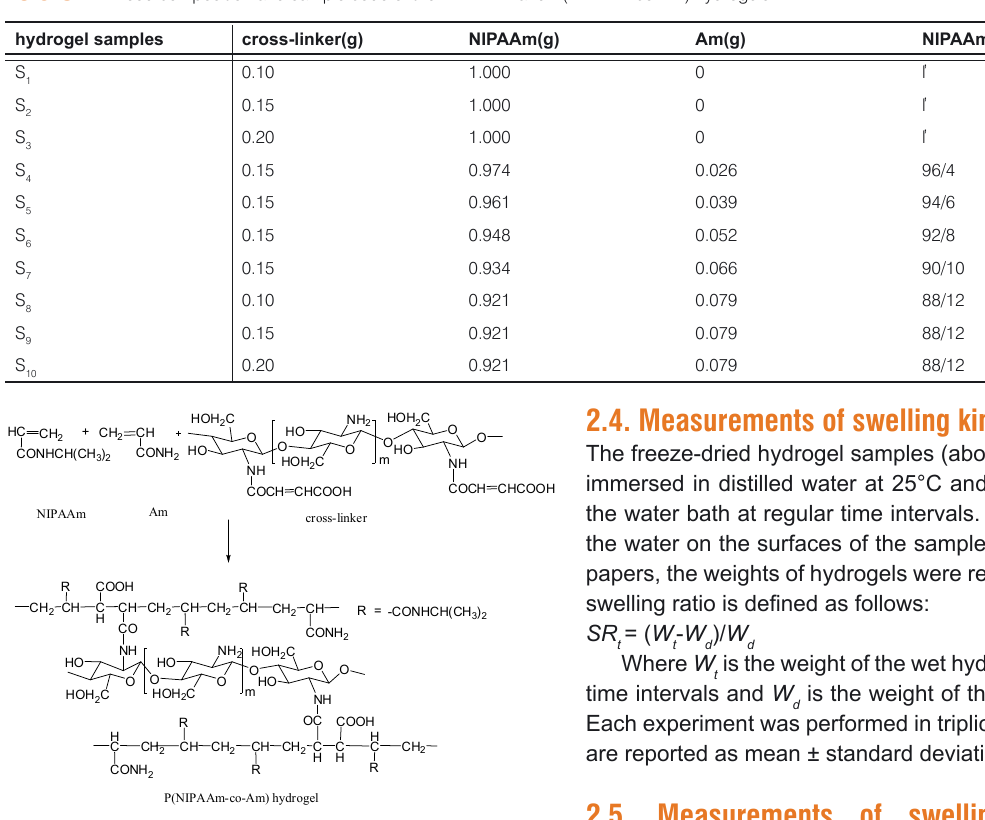
Table 1. Feed composition and sample code of the PNIPAAm and P(NIPAAm-co-Am)